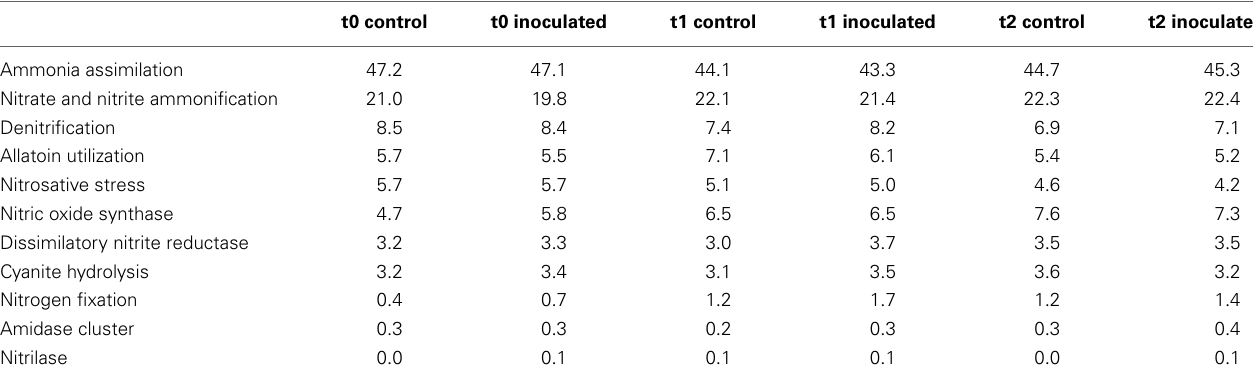
Table 9 | Relative abundances of annotated subsystems within the annotated functional system of nitrogen metabolism.